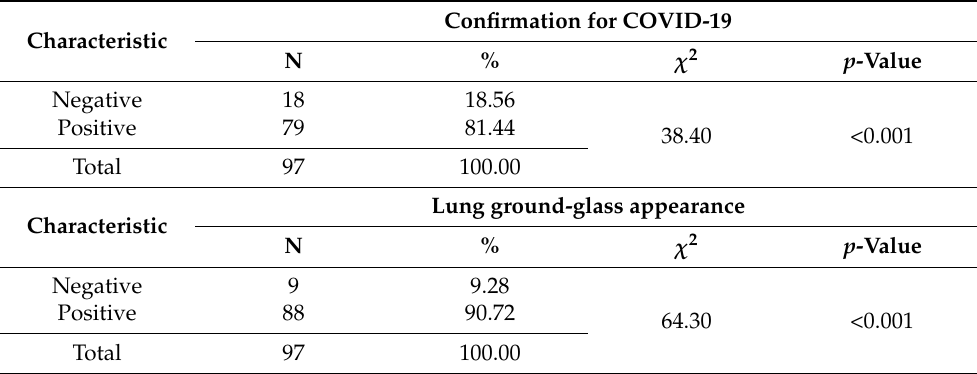
Table 2. Rate of positive laboratory tests and rate of CT scans with characteristic appearance for